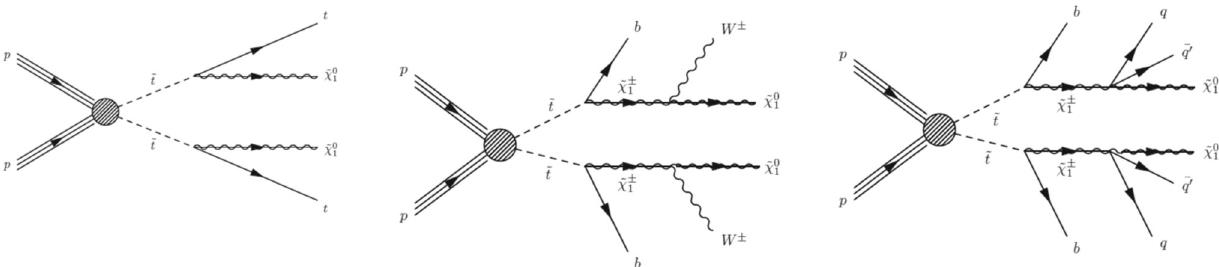
Fig. 1 Topologies for Signal 1 (left), Signal 2 (middle) and Signal 3